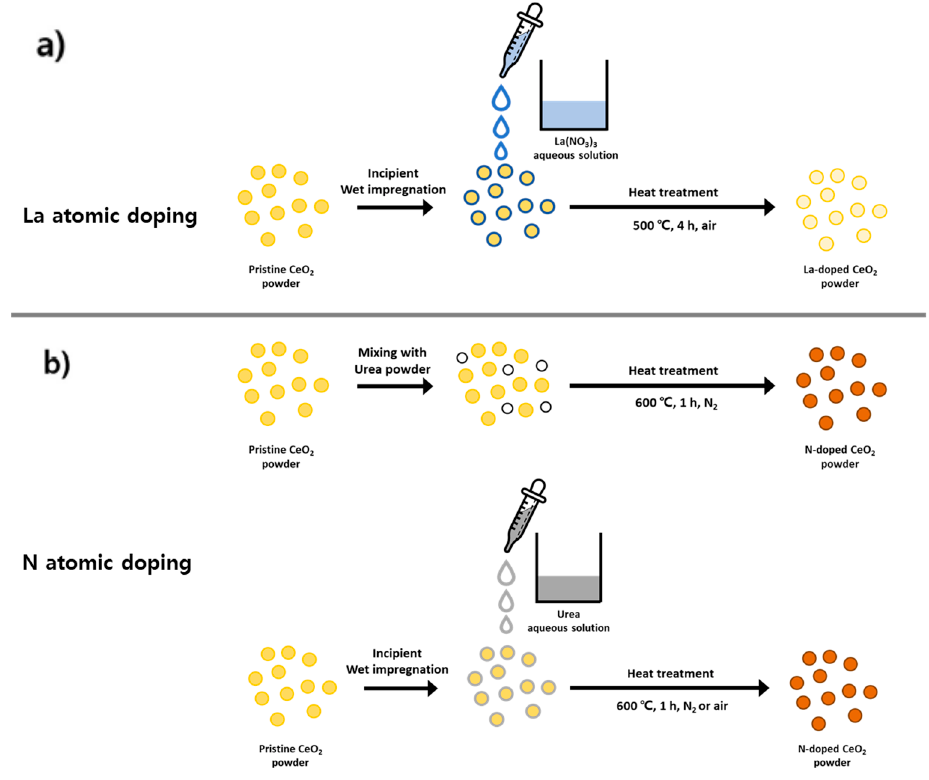
Table 3. Cubic lattice parameter and BET surface area of the pristine CeO 2 and the N-doped CeO 2